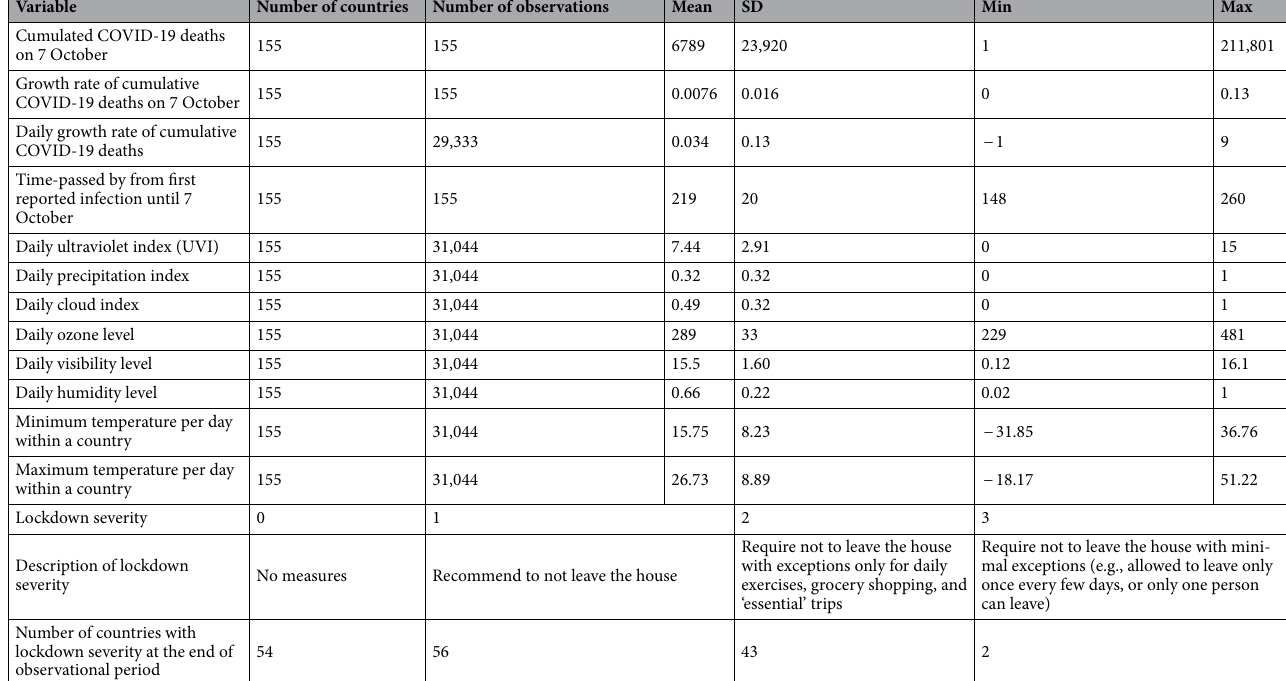
Table 2. Descriptive statistics. We drop the first 20 observations after the first infection in a given country. Therefore, we have 31,044 observations which are less than 76,725 (155 countries × 495